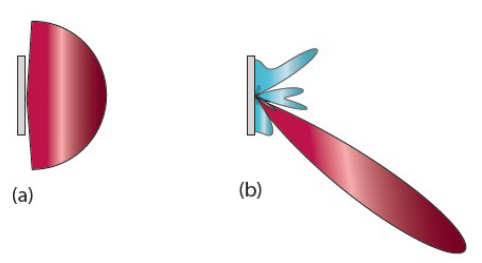
Figure 14. ( a ) A classical antenna, which radiates one signal uniformly, and ( b ) multi-user MIMO antenna, which radiates multiple signals, focused on their respective receivers, reproduced with permission from Björnson, Massive MIMO is a reality—What is next?: Five promising research directions for antenna arrays , published by Elsevier,